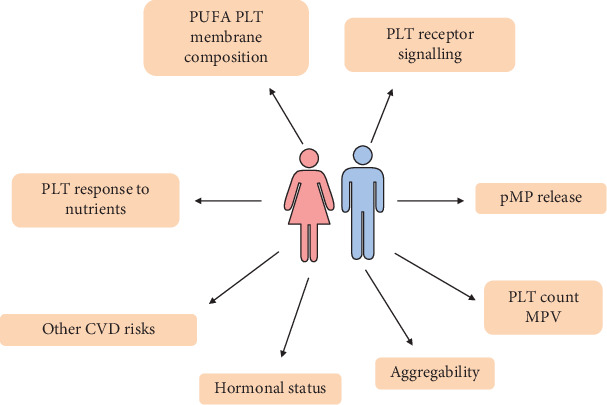
Schematic representation of the main sex-based differences in platelets in relation to cardiovascular disease. See text for details. CVD: cardiovascular disease; MPV: mean platelet volume; PLT: platelet; pMPs: platelet microparticles; PUFA: polyunsaturated fatty acids.